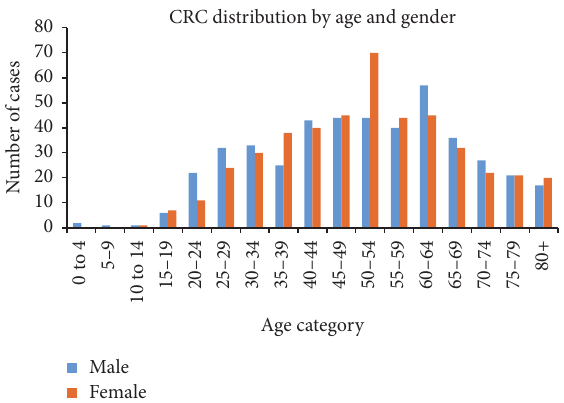
Figure 2: CRC cases distribution by age and gender.